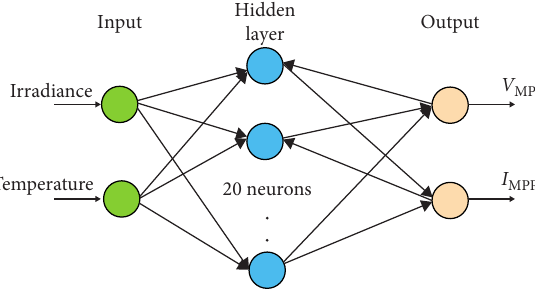
Figure 10: The designed neural network layers.